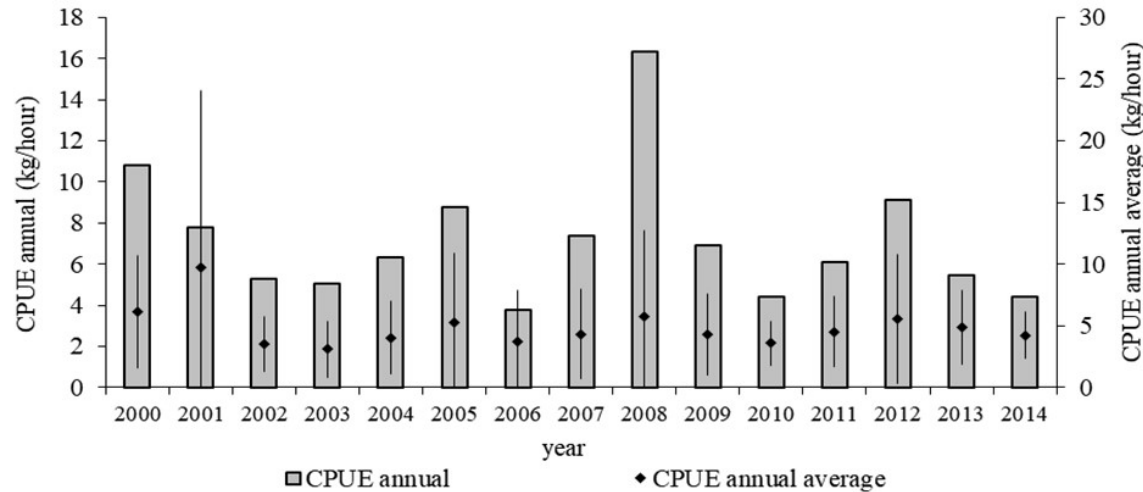
Figure 6. Annual capture per unit effort (kg * h -1 ) and annual average (bars is standard deviation) of marine catfish landings ( Genidens barbus ), in the artisanal fisheries, from 2000 to 2014 on the south coast of São Paulo (Cananeia, Iguape and Ilha Comprida city), with use bottom